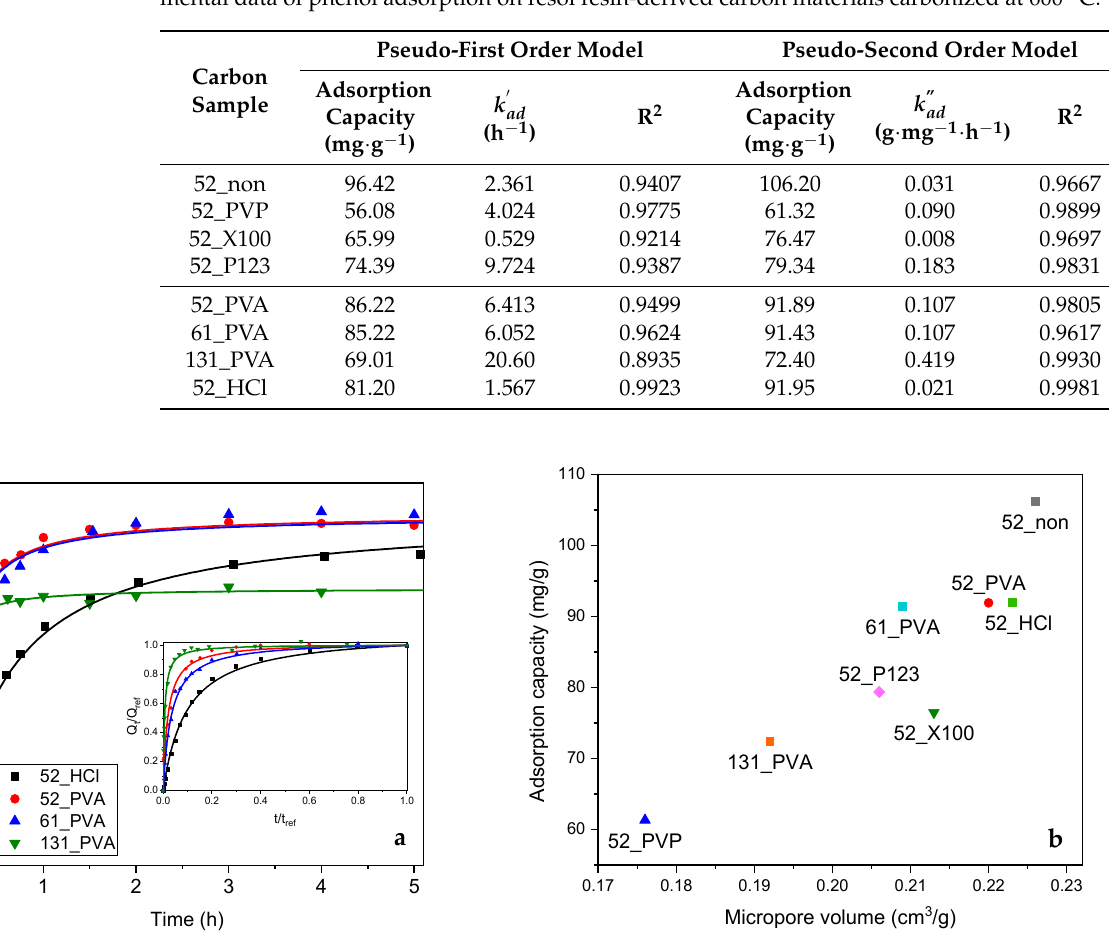
Figure 4. ( a ) Results of adsorption tests in phenol removal from an aqueous solution with fitting by both standard and dimensionless pseudo-second order (PSO) model. ( b ) Relationship between the adsorption capacity and volume of micropores for the studied carbon materials carbonized at 600 °C.